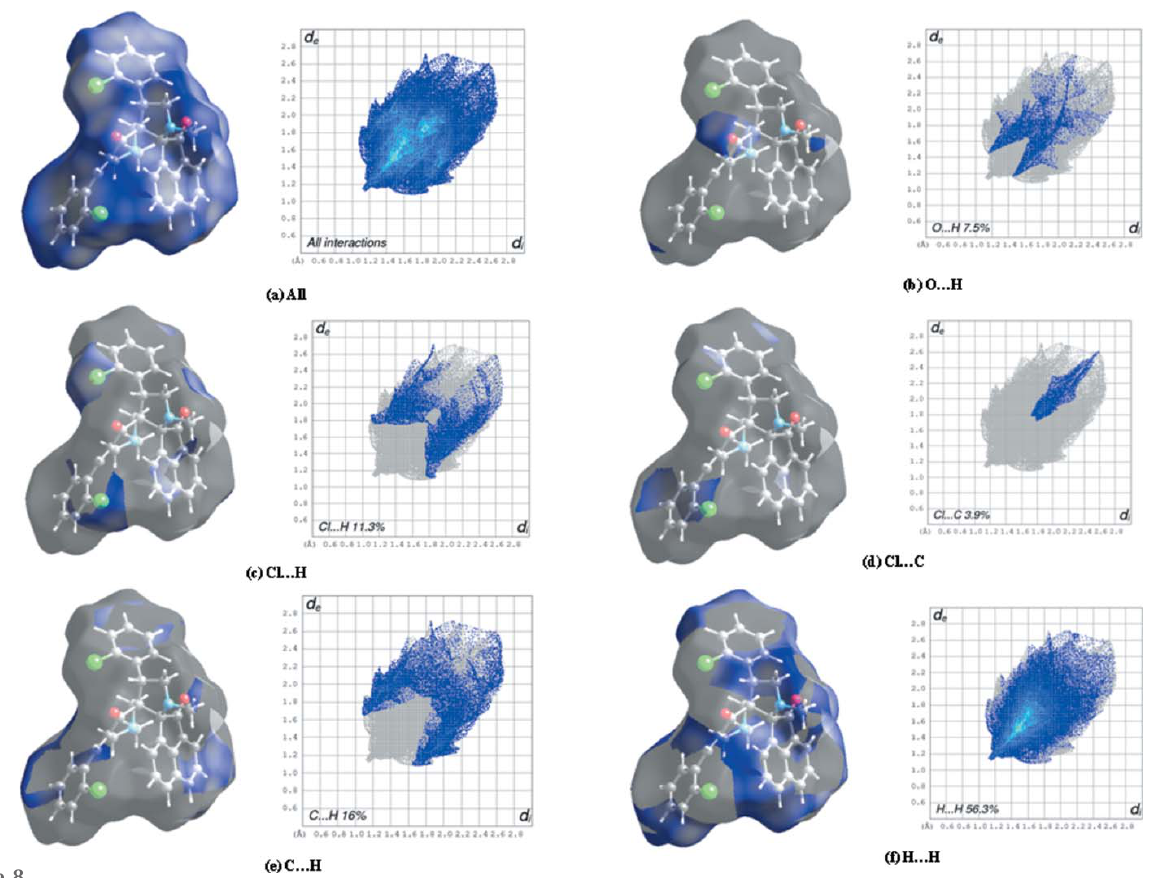
Figure 8 Hirshfeld surface of (I) mapped over shape-index and d norm and decomposed fingerprint plots of the dominant interactions.